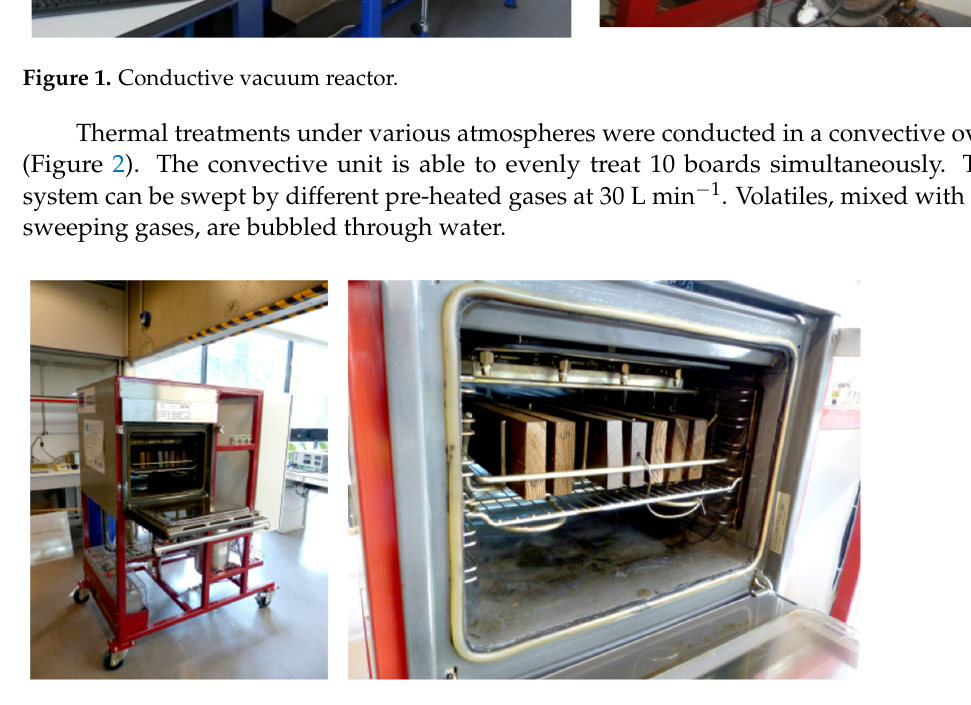
Figure 2. Convective multi atmosphere